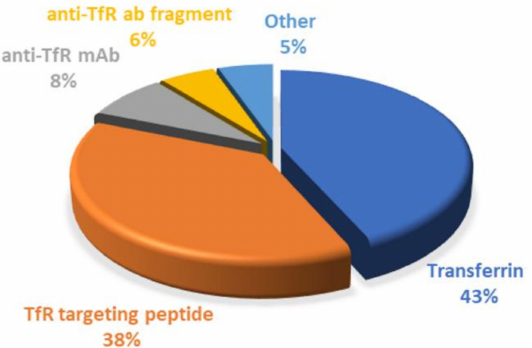
Figure 10. Graphical representation of the distribution of the TfR-targeting started for GBM